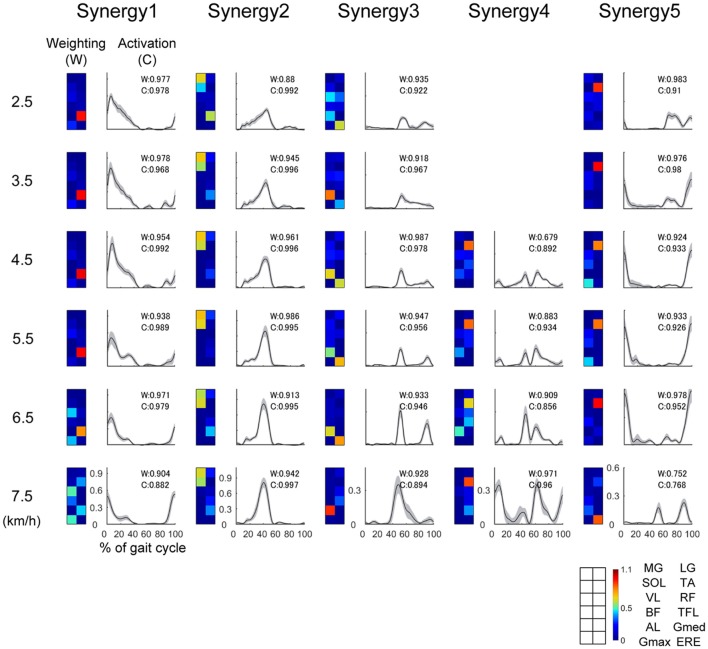
Representative muscle synergies and their activations at 2.5, 3.5, 4.5, 6.7, and 7.5 km/h. The weightings of the muscle synergies (W) are shown as colormaps. Warm color indicates high weightings, and cold color is low weightings. Correspondence between colormap and muscles is described in the lower right of this figure. The activations of the muscle synergies (C) within one gait cycle are shown as waveforms. The horizontal axis indicates % of gait cycle, and vertical axis means amplitude of activation. Black lines denote the average activation over 30 gait cycles, and the gray-shaded area denotes the standard deviation of the activation. We performed functional sorting of the muscle synergies by using cosine similarity (Hagio et al., 2015; Kibushi et al., 2018). Initial functional sorting was performed by grouping the muscle synergies based on the values of cosine similarity compared to that of an arbitrary reference subject. When cosine similarities of W or C were over 0.71 (p < 0.01), the muscle synergies were sorted as similar muscle synergies. If two muscle synergies within one walking speed were grouped into the same muscle synergy group, we defined a pair of muscle synergies with the highest correlation as the same group of muscle synergies (Torres-Oviedo and Ting, 2007; Hagio et al., 2015; Kibushi et al., 2018). After initial sorting, we averaged muscle synergies among subjects and those muscle synergies were sorted again. In this second sorting, reference muscles synergies were set as average muscle synergies. The values of cosine similarities between average muscle synergies and other muscle synergies were indicated at right upper side of plots in the activation. Average muscle synergies were represented in Supplementary Figure 1.